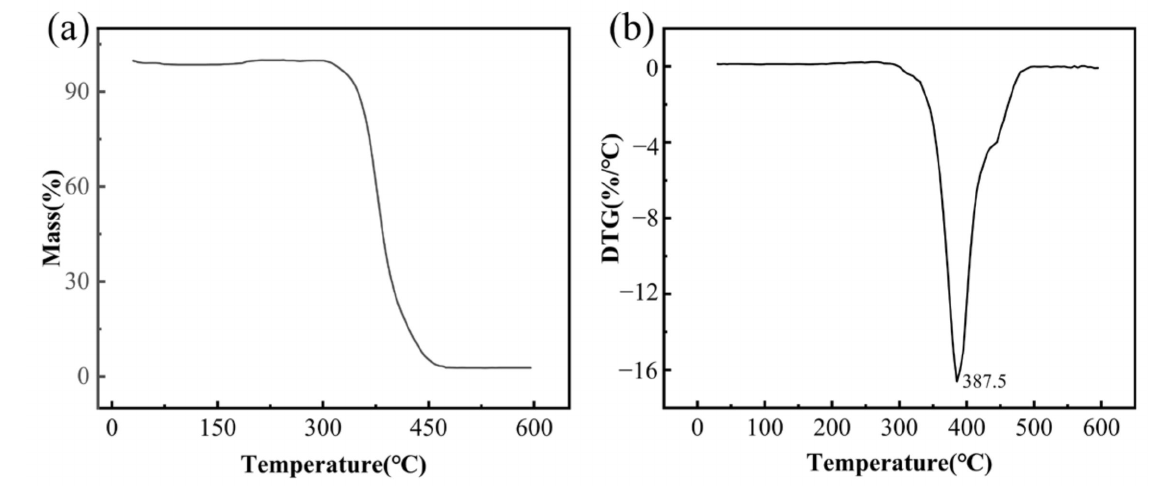
Figure 11. ( a ) TGA and ( b ) DTG curves of the purified gutta-percha.